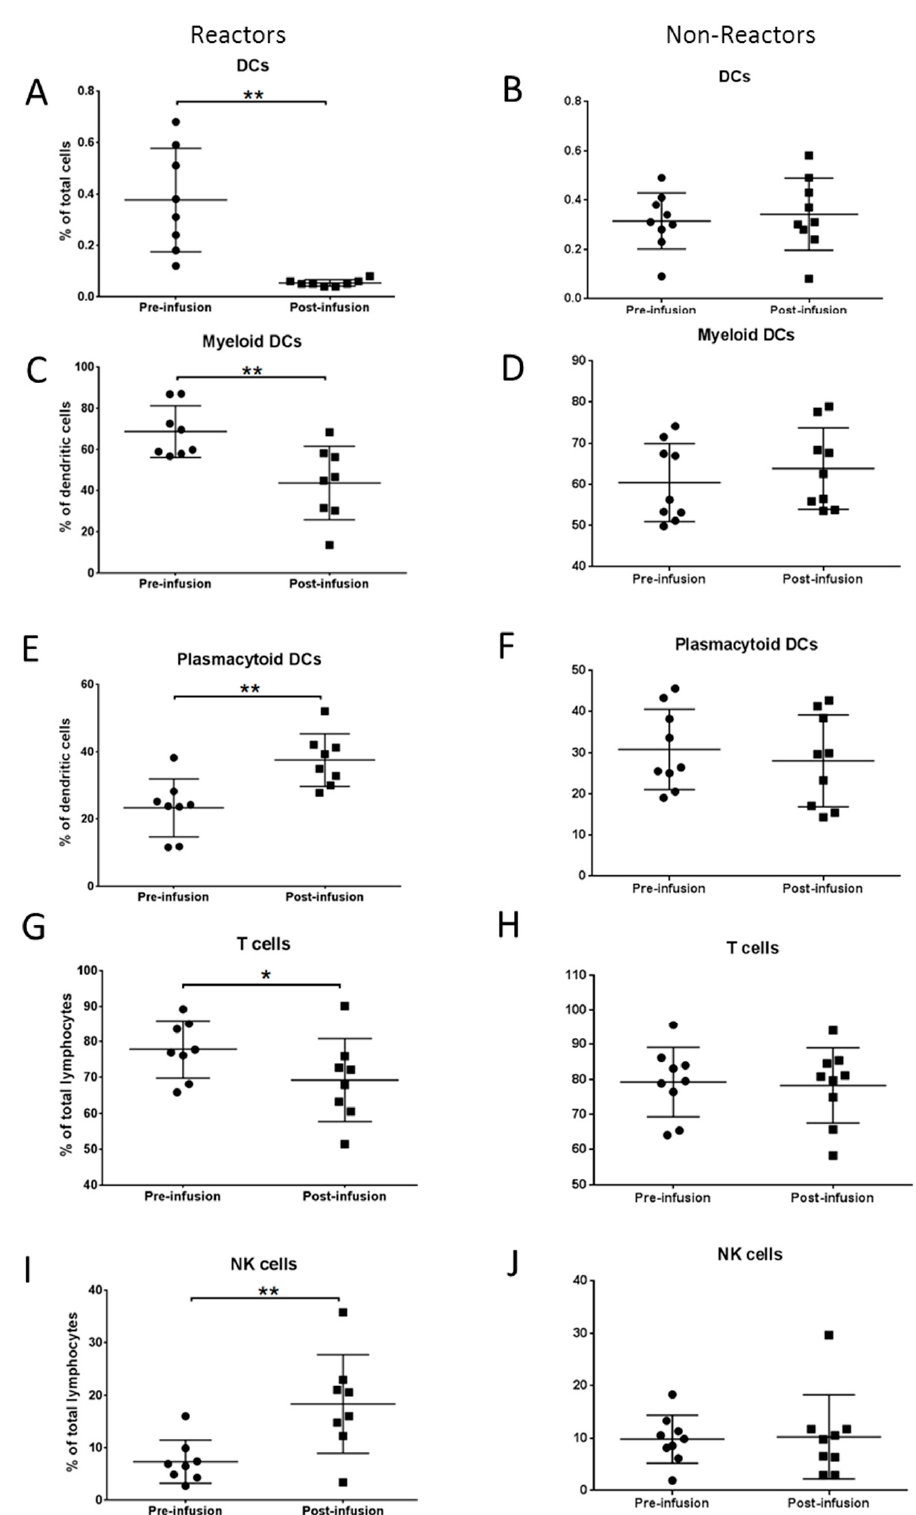
Figure 2. Immunophenotyping at pre- and post-infusion time points from FD patients with IRRs (reactors) and without IRRs (non-reactors). ( A – F ) Significant differences in total dendritic cells and subsets from circulation were observed in reactors compared to non-reactors. ( G – J ) Corresponding differences in circulating T cells and NK cells were also observed. *: p < 0.05; **: p < 0.01.